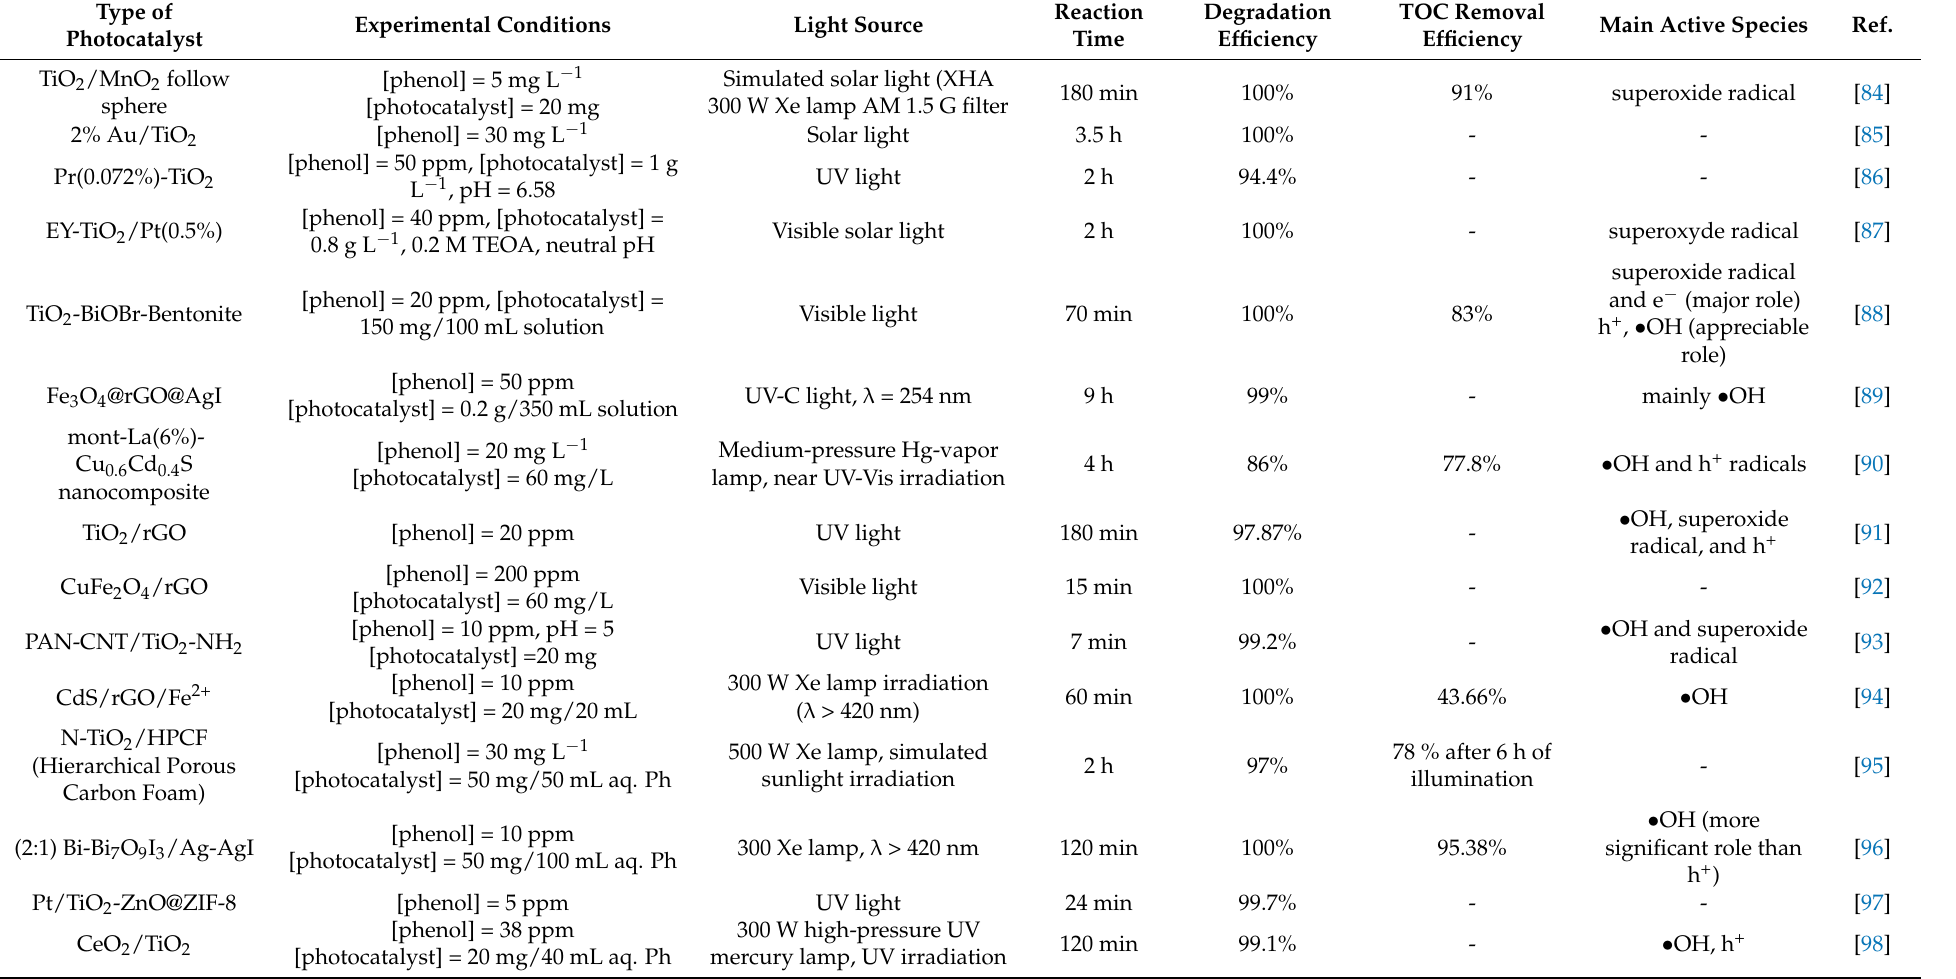
Table 3. Photocatalytic degradation of phenol over various